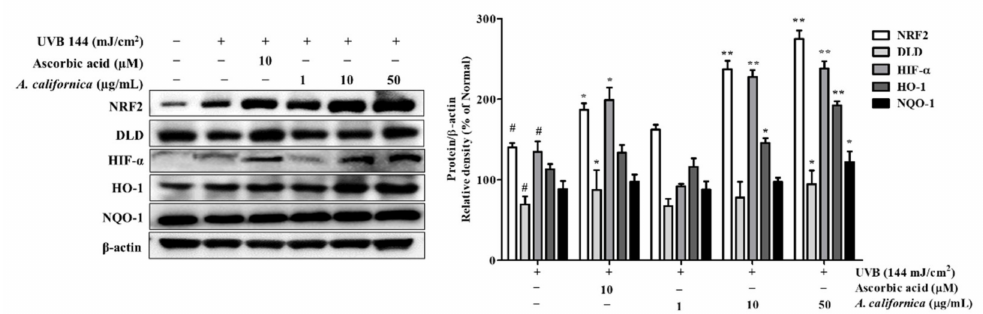
Figure 8. Effect of A. californica extract on the expression of NRF2, DLD, HIF- α , HO-1, and NQO-1 in UVB-irradiated HDF cells. Data are presented as the mean ± SD. # and * indicate significant differences from the non-irradiated control and UVB-treated groups, respectively. # p < 0.05 vs. the non-treated group. *and ** p < 0.05 and 0.01 vs. the UVB-treated control, respectively.